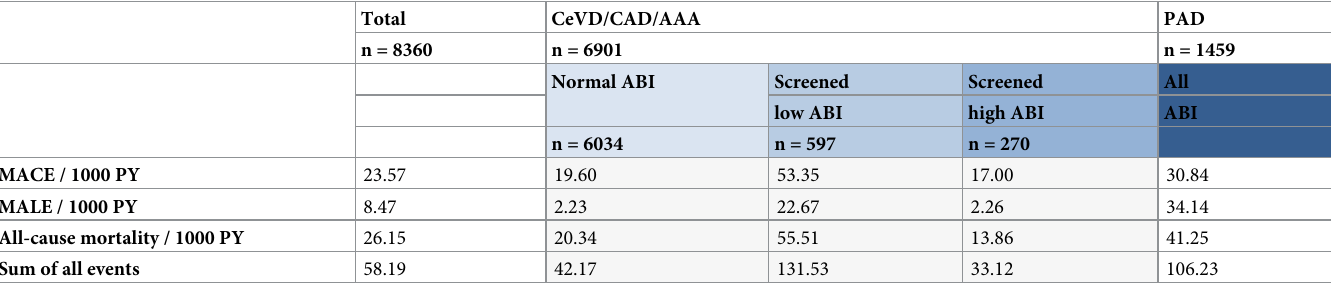
Table 2. Events per 1000 person years.